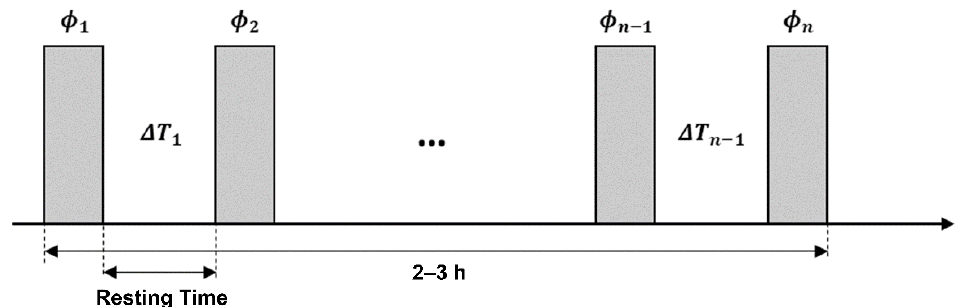
Figure 1. MR temperature experimental scheme. The temperature image ( ∆ T n ) is derived from two successive phase scans ( φ n − 1 − φ n ), whereas the accumulative temperature change (first phase scan to each ∆ T acc . n scan) utilizes the first and the n th phase scans ( φ 1 − φ n ). A resting time of approximately 3 min was adopted between phase scans.